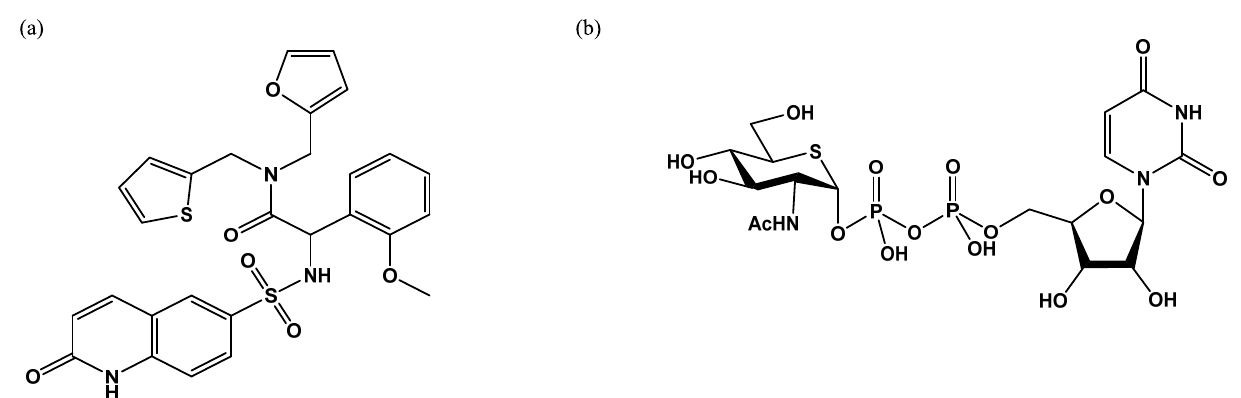
Figure 6. inhibitors assessed with the radiolabelled assay: ( a ) OSMI-1 IC50 = 2.7 μM ( b ) UDP-5S-GlcNAc IC50 = 8 μM. Figure 6. Inhibitors assessed with the radiolabelled assay: ( a ) OSMI-1 IC50 = 2.7 µ M ( b ) UDP-5S-GlcNAc IC50 = 8 µ